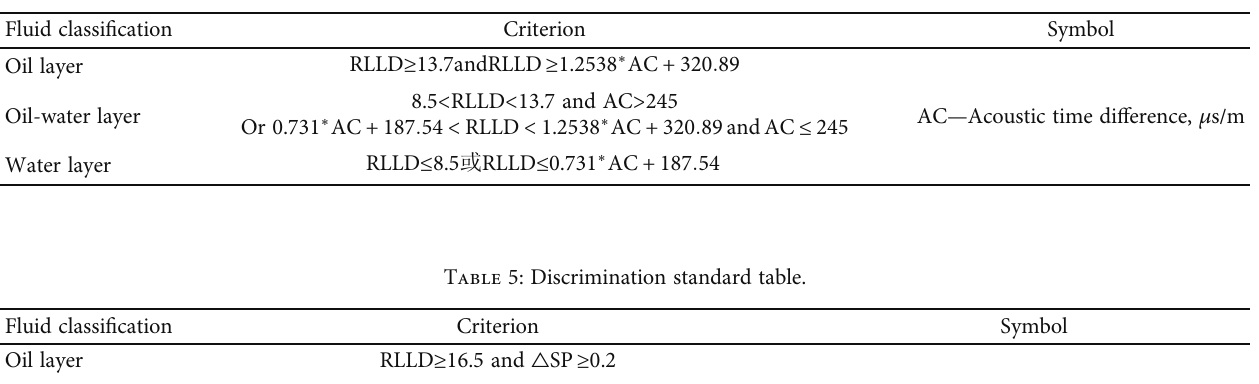
Table 4: Discrimination standard table.